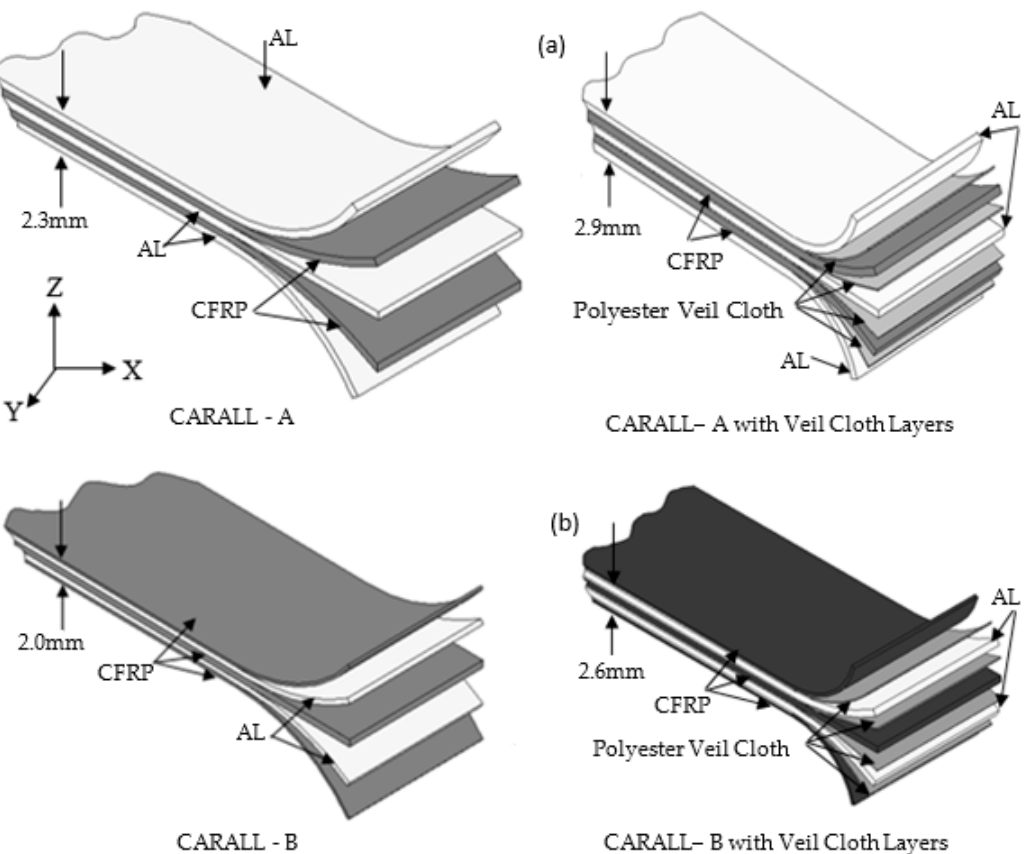
Figure 4. Carbon fiber/epoxy—aluminum laminates’ nomenclature and stacking sequence. ( a ) CARALL-A specimen schematic ( b ) CARALL-B specimen schematic.